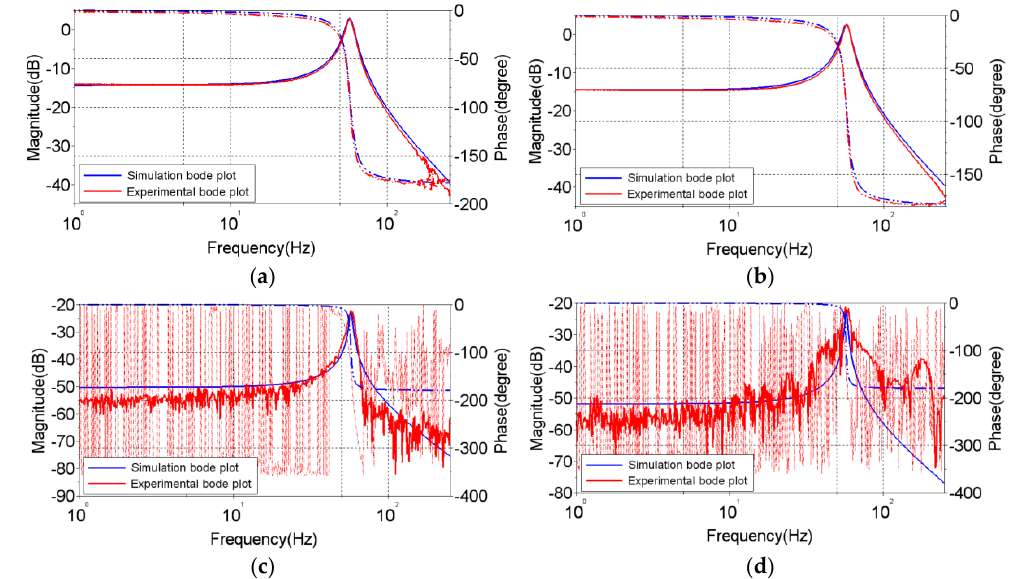
Figure 6. Experimental and simulated Bode plots of the nonlinear Equations (18)–(20) of OIS. ( a ) Experimental and simulated Bode plots of nonlinear OIS in x axis with VCM driving along x axis, showing a resonance at 57.59 Hz; ( b ) Experimental and simulated Bode plots of nonlinear OIS in y axis with VCM driving along y axis, showing a resonance at 57.39 Hz; ( c ) Experimental and simulated Bode plots of nonlinear OIS in x axis with VCM driving along y axis, showing a resonance at 57.60 Hz; ( d ) Experimental and simulated Bode plots of nonlinear OIS in y axis with VCM driving along x axis, showing a resonance at 57.40 Hz.